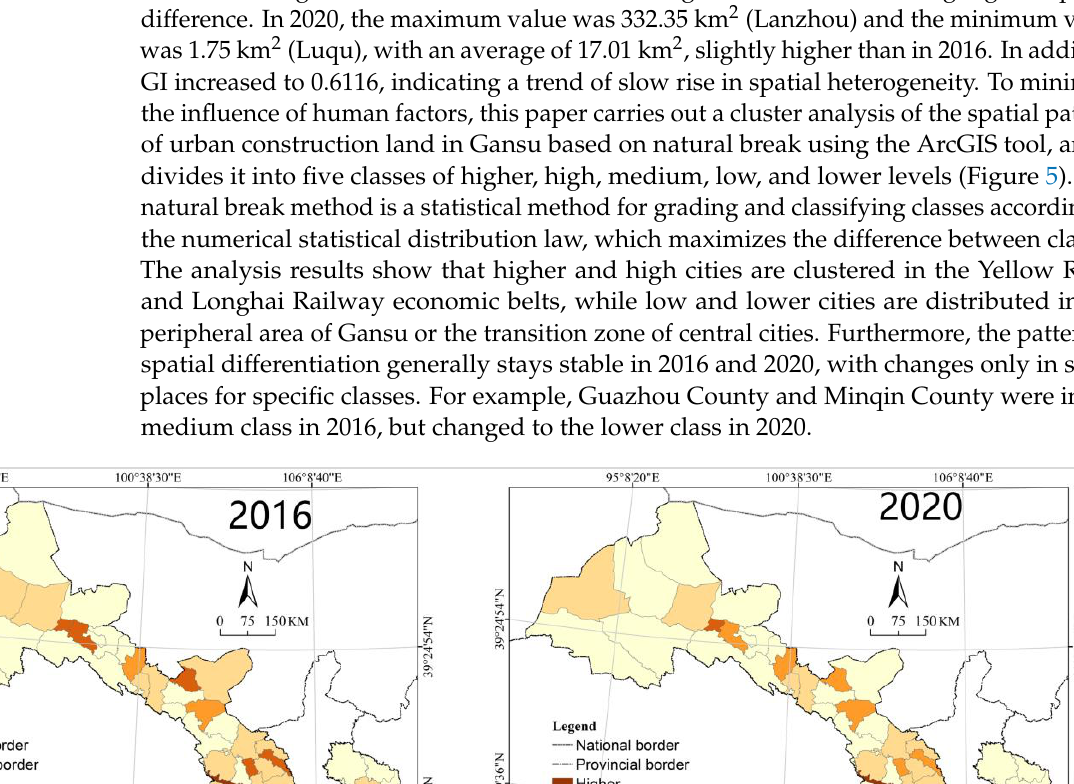
construction land. The tool of cold/hot spot analysis is to identify areas with statistically significant clustering, as it indicates that urban construction land change is being influ- enced by some spatial process factors and there is spatial correlation. The hot and the cold spots represent areas or locations where cities with high or low values of urban construc- for the spatial cold and hot spot method show that both hot and cold spot areas of urban construction land were clustered together in 2016 and 2020, with cold spot areas distrib- uted in a solid pattern but the hot spot areas clustered in different geographical regions.